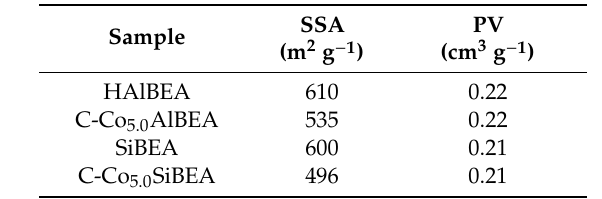
Table 1. The specific surface area (SSA) and pore volume (PV) of HAlBEA, C-Co 5.0 AlBEA, SiBEA and C-Co 5.0